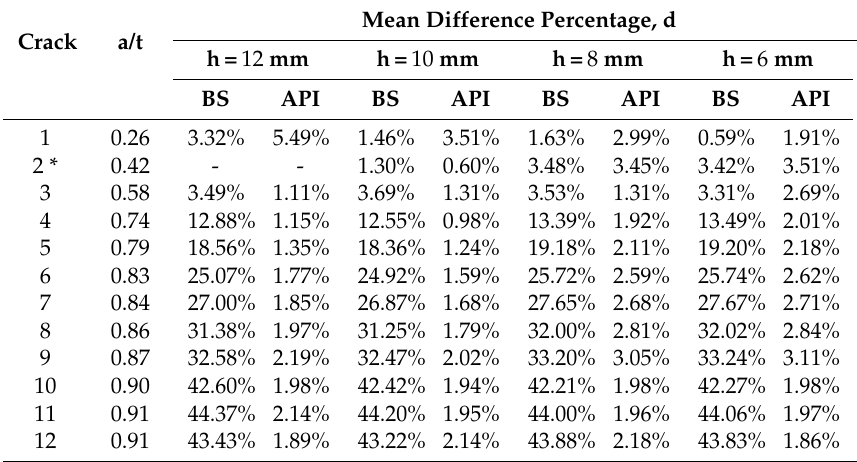
Table 4. Convergence of mesh size for each model.